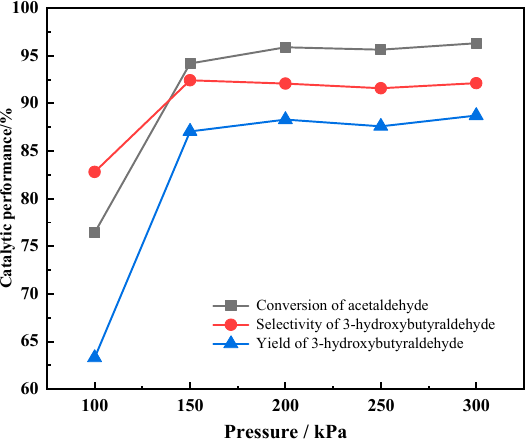
Figure 9. Effect of reaction pressure on AcH condensation.